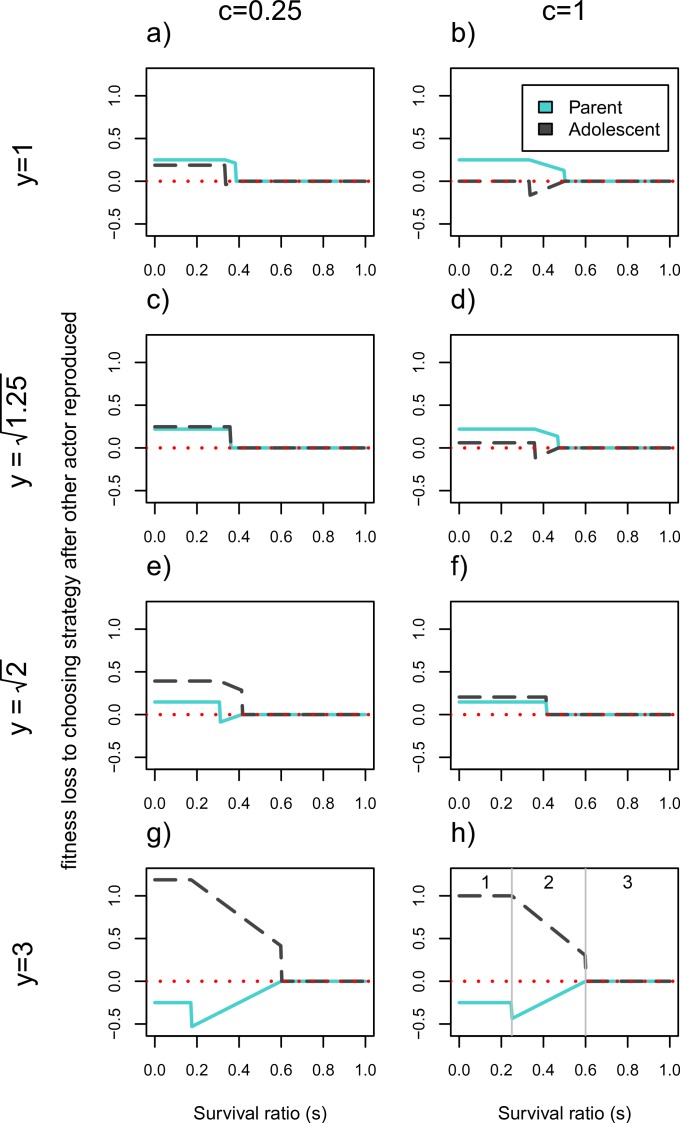
Cost of choosing strategy after the other actor has reproduced.Fitness losses are plotted as a function of the survival ratio, s, of 2 vs. 1 infant in the household. The solid line denotes the older generation (i.e., the parent), and the dotted line denotes the younger generation (i.e., the adolescent). The larger the fitness losses from not reproducing first, the more likely the actor is to win the conflict. Values of c = 0.25 and c = 1 represent low and high parental continuity respectively, and increasing values of y represent higher fitness of the younger generation’s infant. When y = 1 there is no senescence. Intermediate y values correspond to values of \documentclass[12pt]{minimal}
\usepackage{amsmath}
\usepackage{wasysym}
\usepackage{amsfonts}
\usepackage{amssymb}
\usepackage{amsbsy}
\usepackage{upgreek}
\usepackage{mathrsfs}
\setlength{\oddsidemargin}{-69pt}
\begin{document}
}{}$y=\sqrt{(1+c)}$\end{document}y=1+c for c = 0.25 and c = 1 respectively. At these values the payoffs work out such that the actors never disagree about whether there should be two or one infant in the household. Plot (H) shows the limits of three functionally different zones; zone (1) where only one actor will reproduce, (2) where the number of infants produced will depend on who reproduces first, and (3) where both actors will reproduce. The corresponding zones can be found in all other plots except for (C) and (F) where zone 2 disappears.